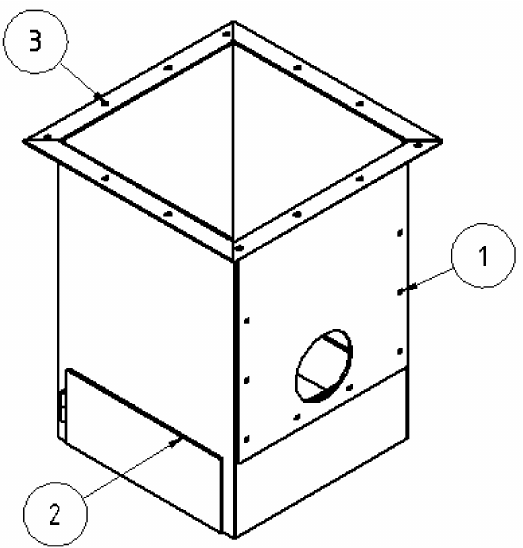
Figure 3. Combustion